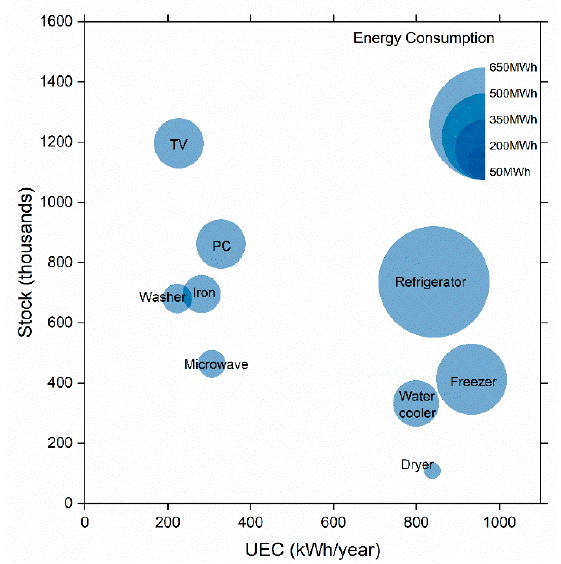
Figure 8. Electrical energy consumption of selected household appliances in Kuwait.